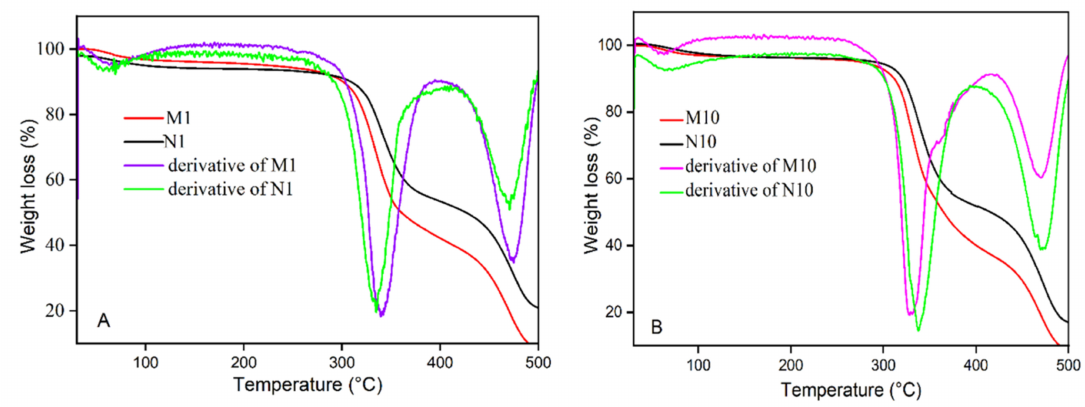
Figure 3. ( A ) TGA curves of M1 and N1, ( B ) TGA curves of M10 and